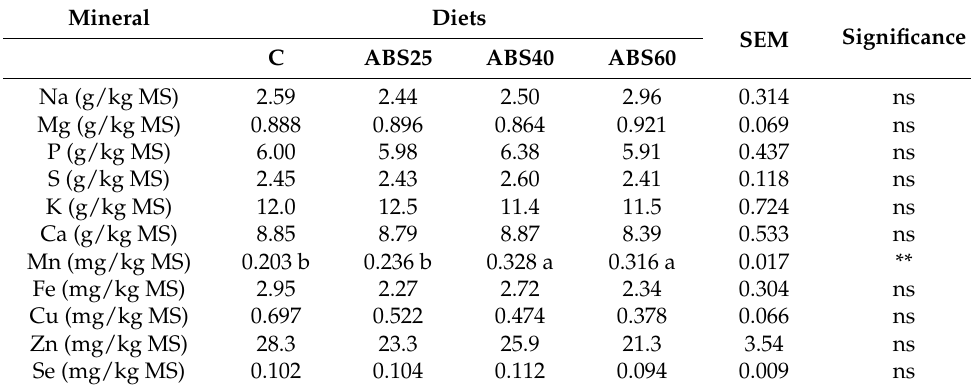
Table 3. Milk mineral profile according to the effects considered.